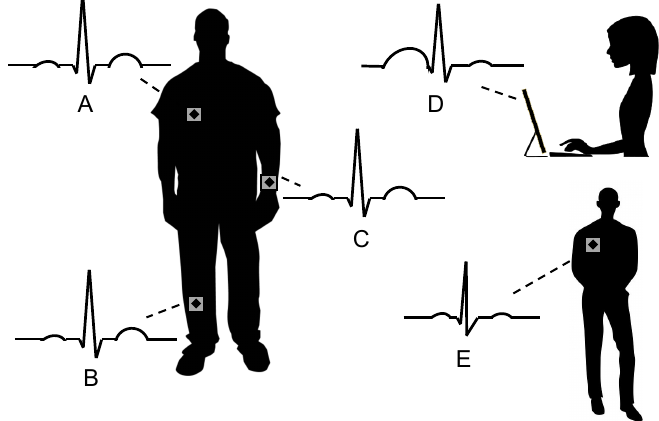
Figure 1. A BAN comprises sensors attached to a human body. Electrocardiography (ECG) data can ensure that sensors, attached to the same body ( A,B,C ) trust each other but do not trust sensors ( E ) and devices ( D ) that are not attached to the same